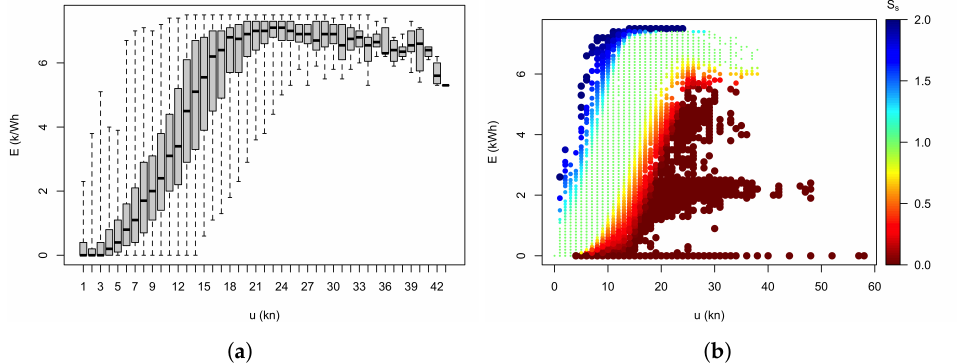
Figure 3. ( a ) Empirical performance curve as a set of boxplots for each wind speed bin from the training data; ( b ) scatter plot of the validation data, with colour coding for the performance score, S s , for each